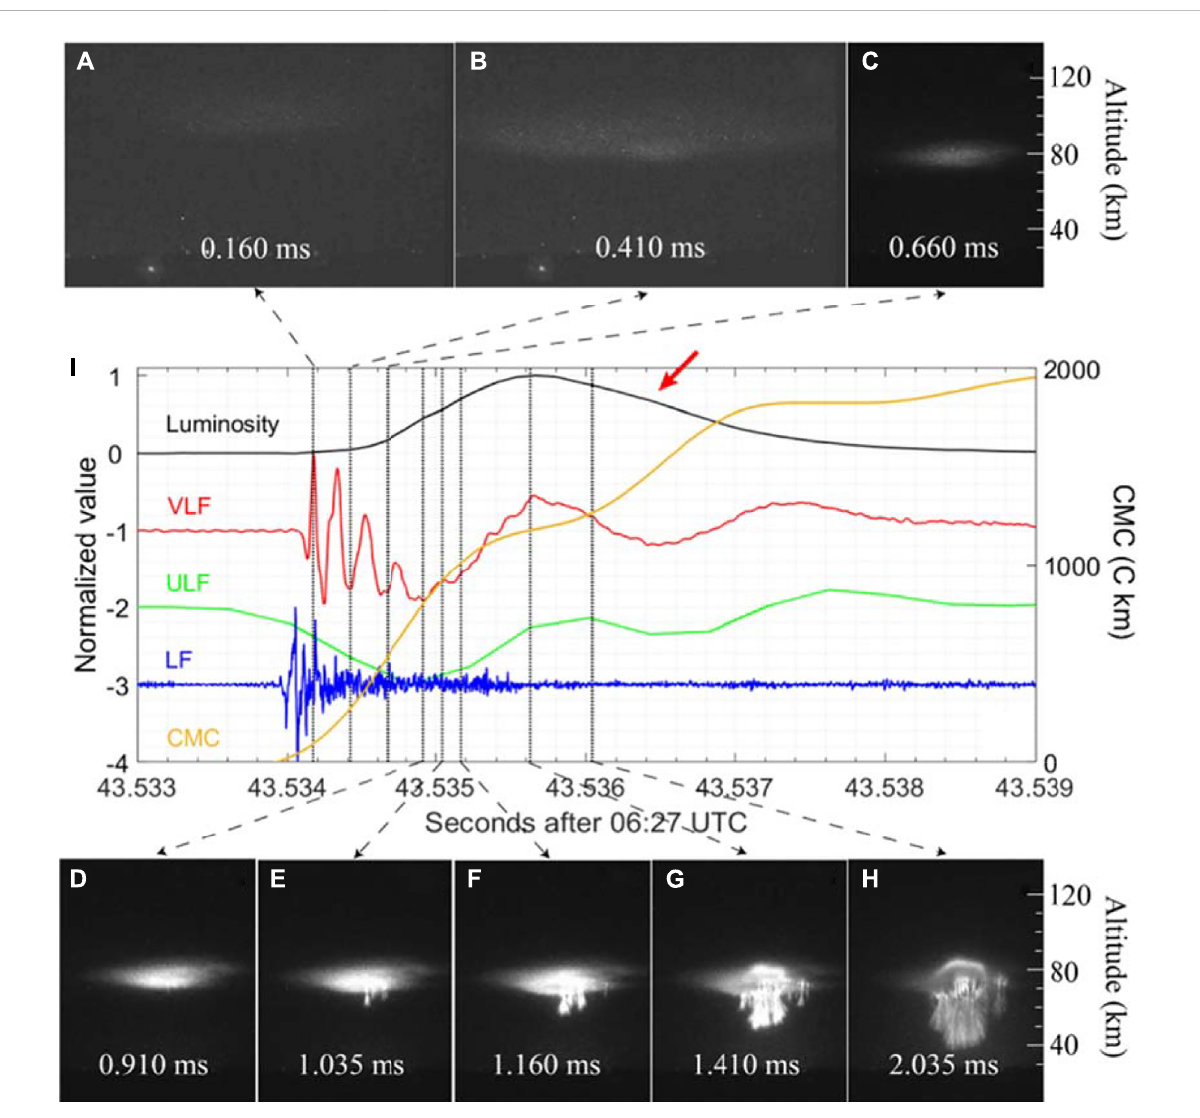
FIGURE 8 Examining the evolution of a halo-sprite event captured with the high-speed camera by comparing with the broadband lightning sferics [panel (I) ]. The static images obtained by the high-speed observations were given in panels (A – H) . Adopted from Ren et al. (2021).